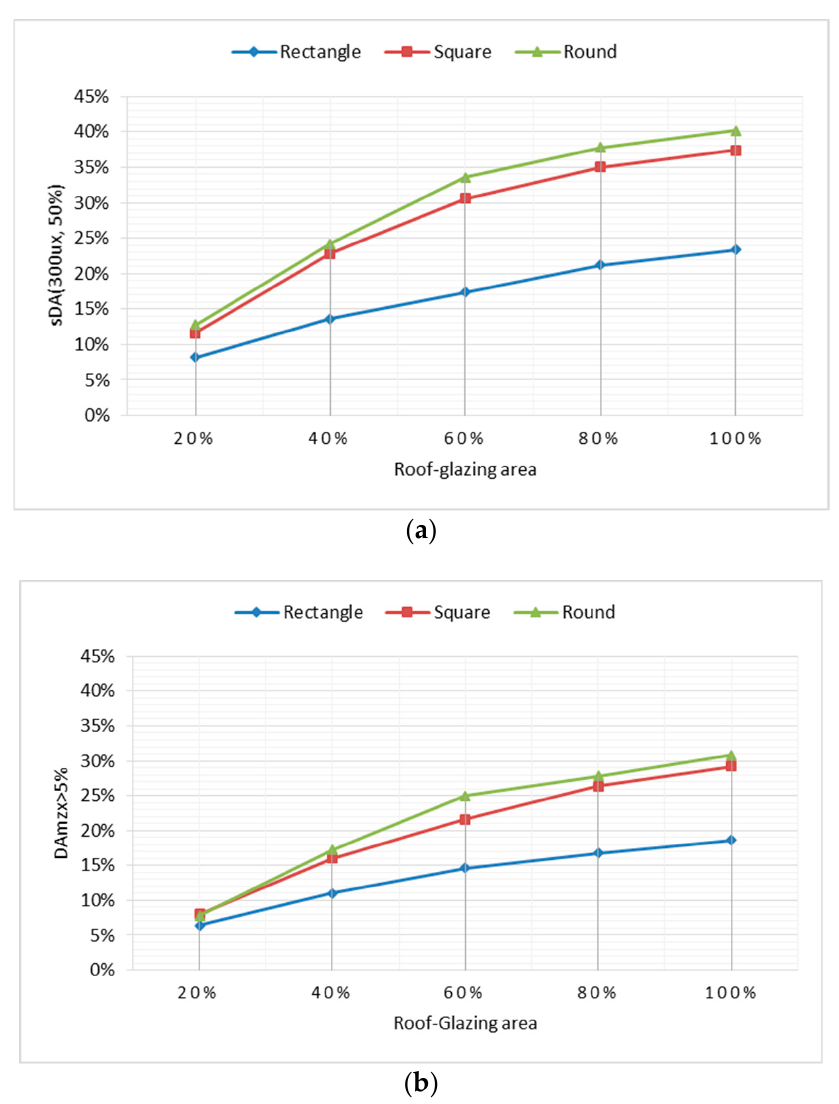
Figure 5. Daylight performance comparison of atrium types. ( a ) sDA(300 lux, 50%) values in different atrium types; ( b ) DA_MAX > 5% values in different atrium types.